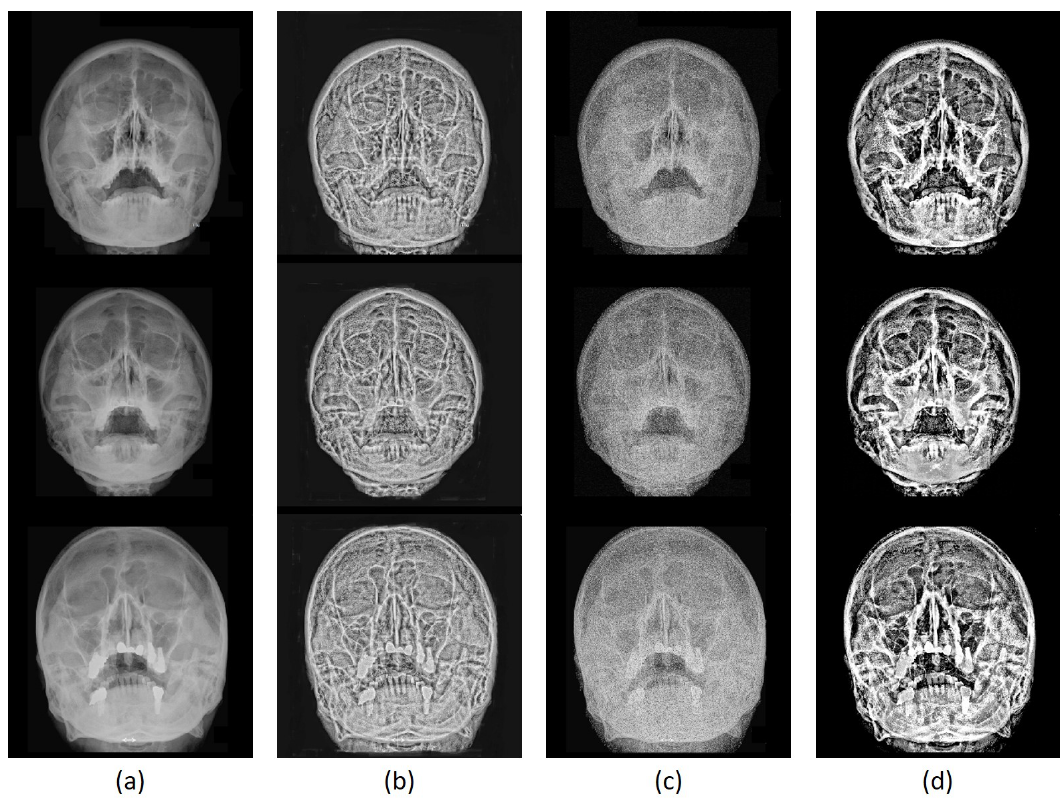
Figure 3. Experimental result montages of various enhancement schemes. ( a ) Original SXR images from the negative N , the positive P , and the unknown folds ( U − N , U − P ) of the dataset (top–bottom). ( b ) Enhanced images from the HM-CLAHE [7]. ( c ) Enhanced images from the LCE-BSECSC [8]. ( d ) Enhanced images from the proposed ToMA